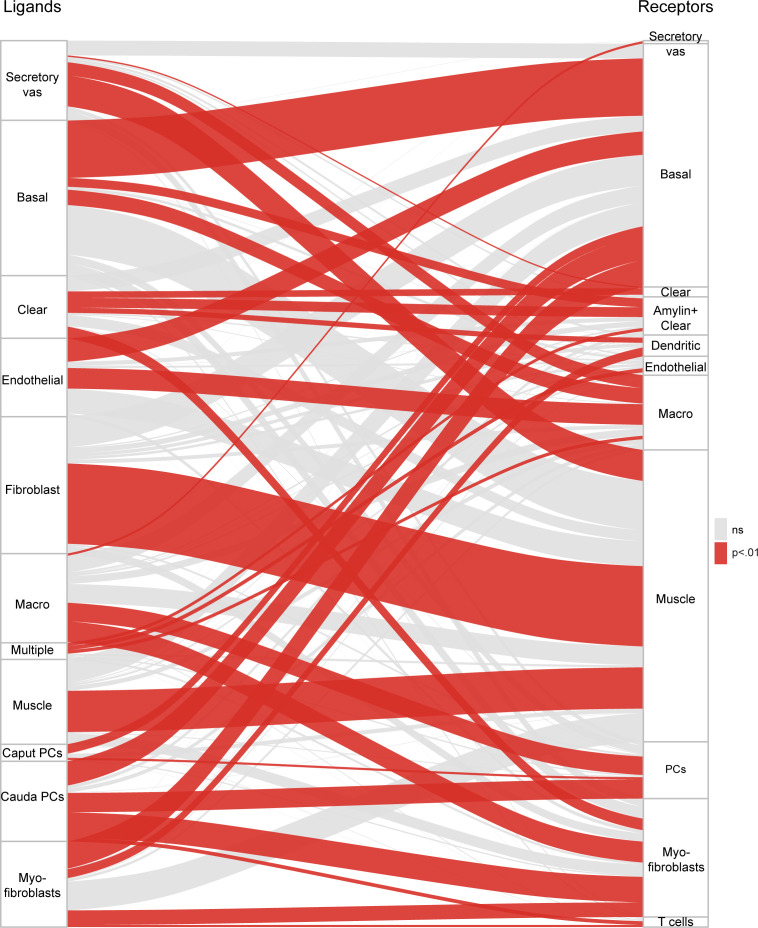
Potential signaling interactions between epididymal cell types.Bars on left and right show clusters of ligands and receptors (see Supplementary file 4) named according to the cell population with highest expression levels. For brevity, principal cells were abbreviated as ‘PC’. Rectangle lengths represent the number of putative connections between ligands (left panels) and receptors (right panels) expressed in different cell types. Lines connecting rectangles represent connections between matching ligand-receptor pairs expressed. If the number of interactions between a cell type is equal or less than the number expected by chance (based on the number of expressed ligands and receptors in the pair of cell types, hypergeometric test), lines are grey, while lines are colored red for cell type pairs with a significant enrichment of matching ligand-receptor pairs. See Supplementary file 4 for ligand and receptor expression in the 34 cell populations.